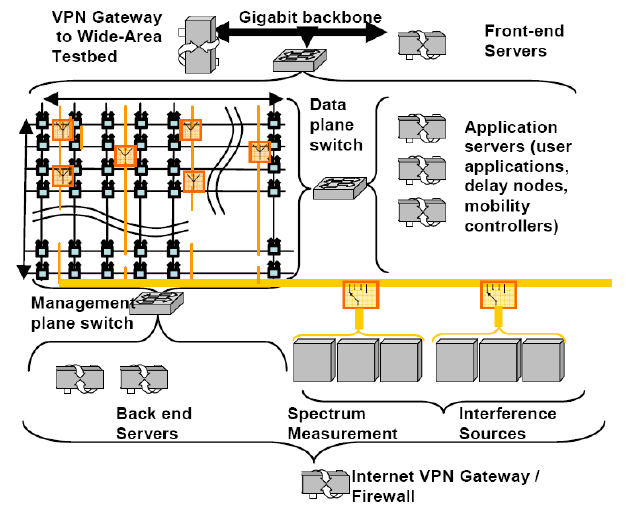
Figure 12. Orbit system architecture.